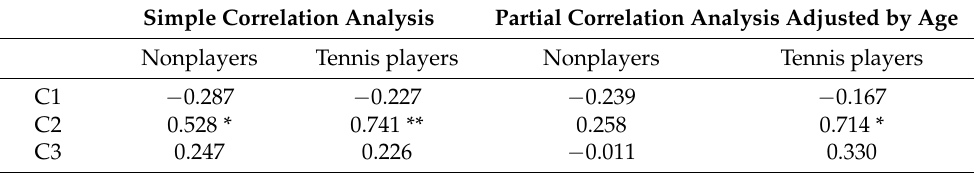
Table 7. Correlation between the FMD and Cluster 1, Cluster 2, and Cluster 3.